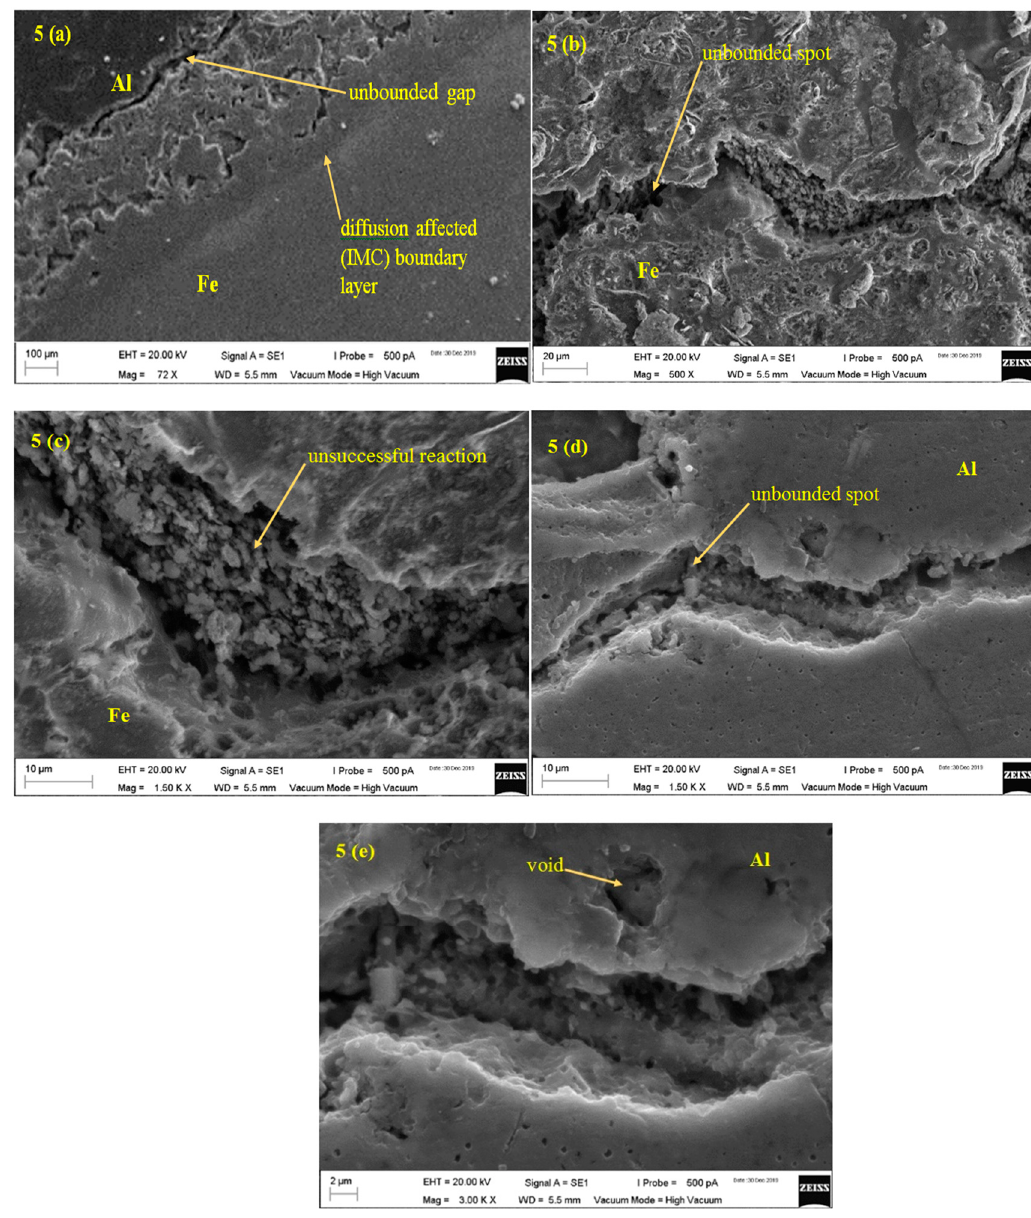
Figure 5. Topography of specimens; Figure 5( a ) Topography of Al–Fe joint at 72 magnification Cross Section by SEM; Figure 5( b ): Topography of Al–Fe joint at 500 magnification Cross Section by SEM; Figure 5( c ): Topography of Al–Fe joint at 1500 magnification Cross Section by SEM; Figure 5( d ): Topography of Al–Fe joint at 1500 magnification Cross Section by SEM; Figure 5( e ): Topography of Al–Fe joint at 3000 magnification Cross Section by SEM .